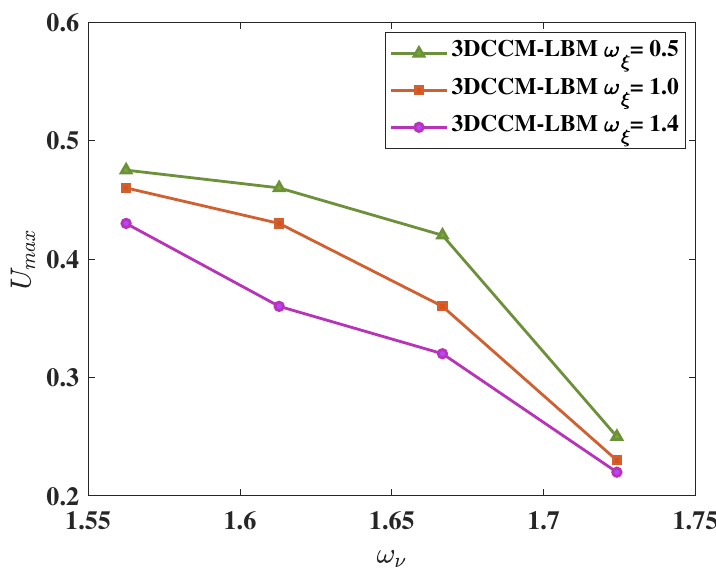
Figure 13. Numerical stability results of the 3DCCM-LBM showing the maximum threshold velocity of the lid U in a 3D lid driven cubic cavity flow at different values of the relaxation parameter corresponding to the shear viscosity obtained for three different values of the relaxation parameter controlling the bulk viscosity, i.e., ω ξ = 0.5,1.0, and 1.4.